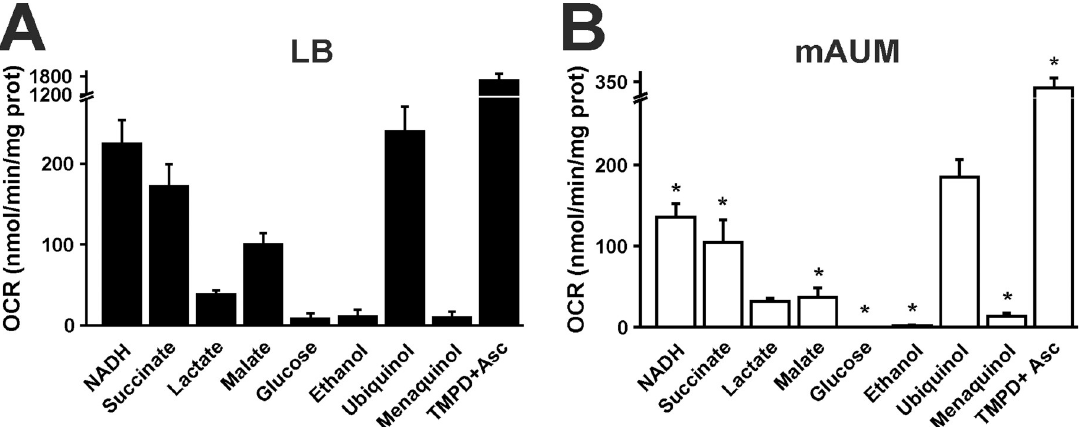
Fig 3. P . aeruginosa respiratory activity in LB and mAUM membranes. Oxygen consumption rate (OCR) of membranes obtained from bacteria grown in LB (A) or mAUM (B). Oxygen consumption was measured in KHE buffer in the presence of the next substrates: 200 μ M NADH, 10 mM succinate, 10 mM lactate, 10 mM glucose, 0.3% ethanol, 50 μ M ubiquinol or 50 μ M menaquinol or 100 μ M TMPD + plus 5 mM ascorbic Acid. Bars represent mean ± S.D. n � 3. � , p < 0.05 after t test between LB and mAUM.